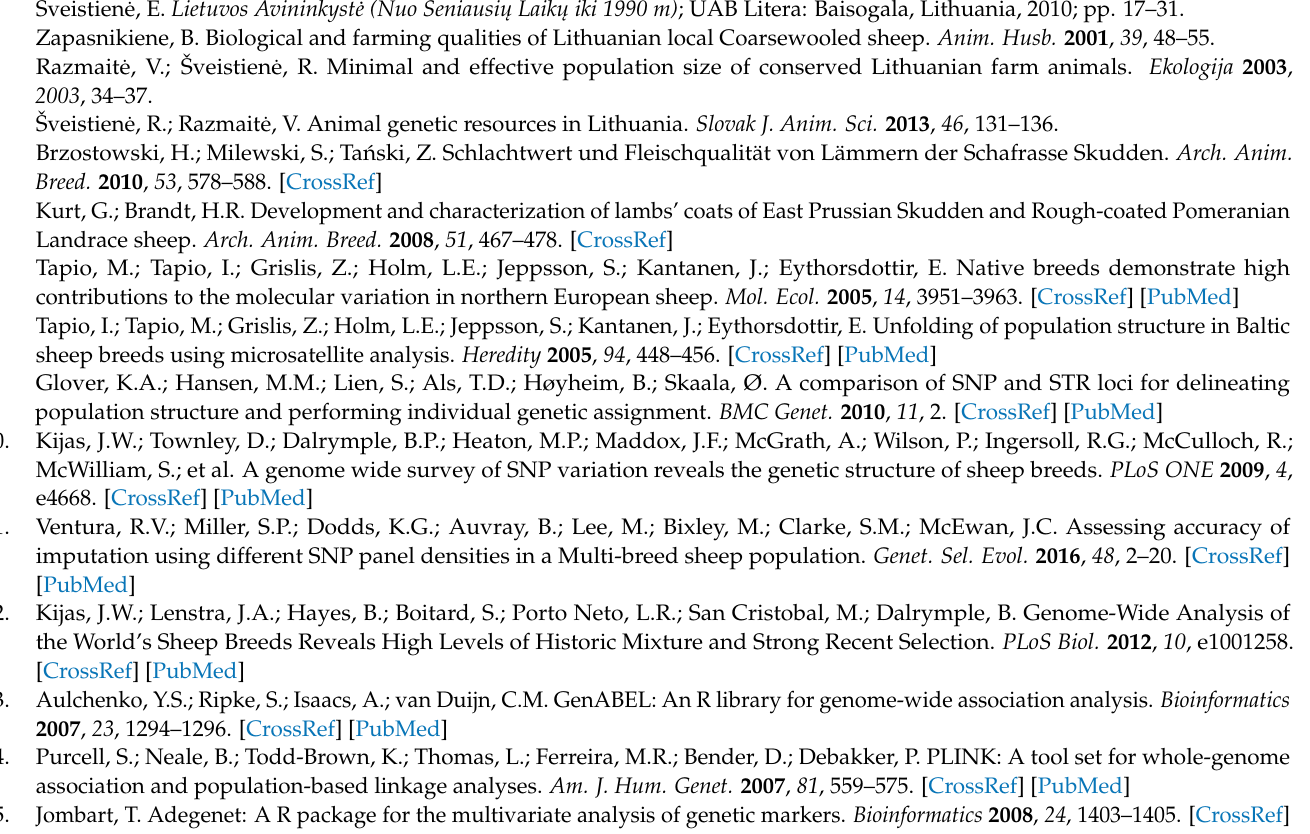
used chain lengths. Figure S3: Model-based clustering results for k values 15 to 18. The model k = 17 had the highest log-likelihood among the tested